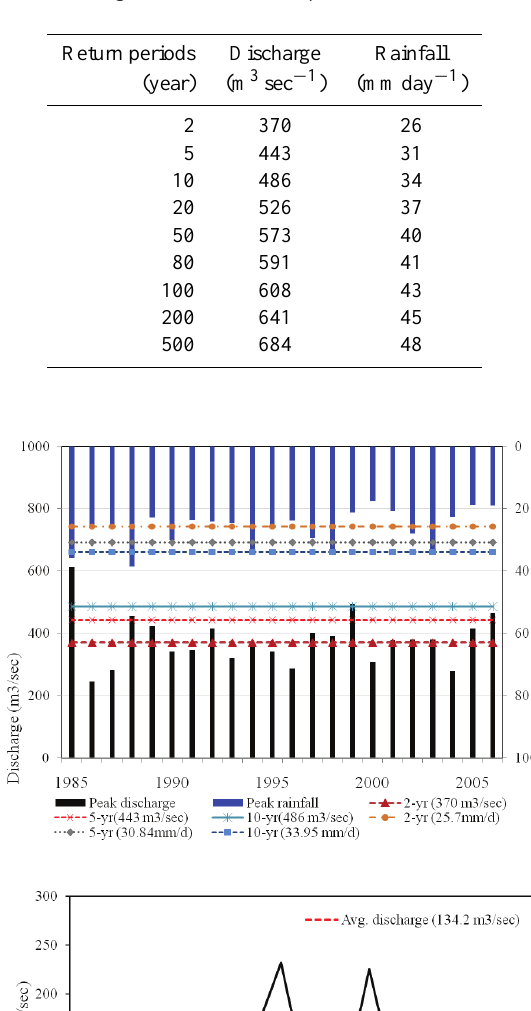
Table 3. Discharge and rainfall return periods.